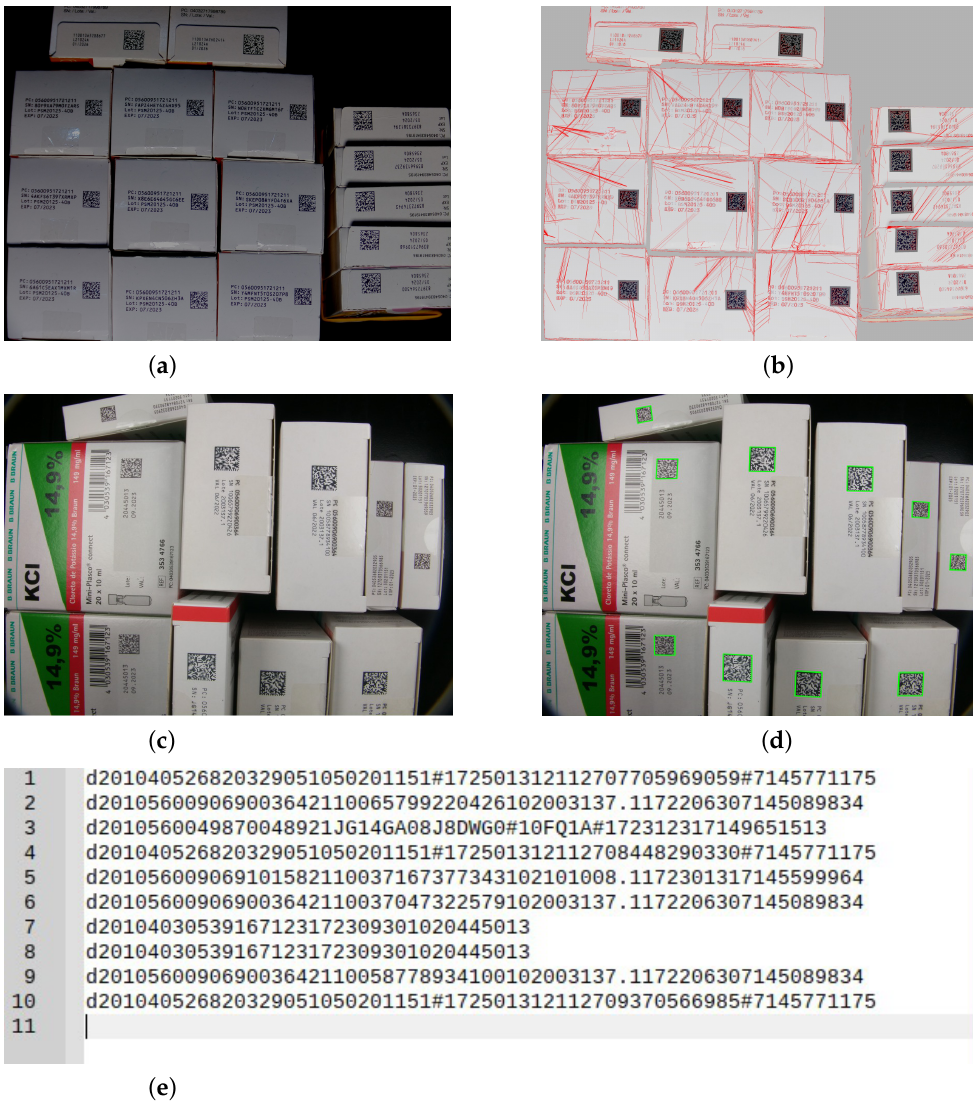
Figure 8. Scanning process: ( a ) Acquired image with 16 codes; ( b ) libdmtx scanning output; ( c ) Original image; ( d ) Data Matrix identified by the library; ( e ) The extracted codes according to the defined protocol (libdmtx codes output, as read by a commercial data matrix